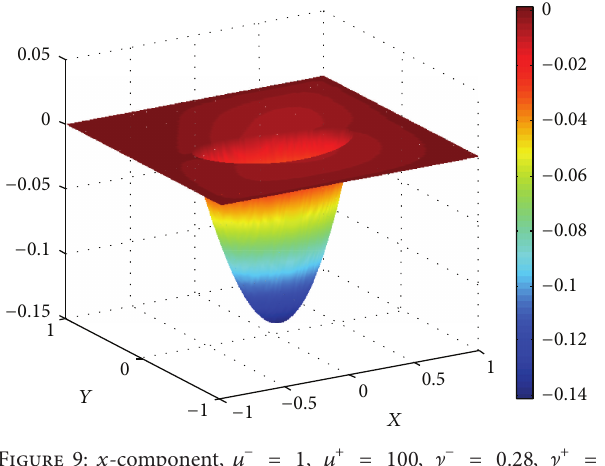
Figure 9: 𝑥 -component, 𝜇 − = 1, 𝜇 + = 100, ] − = 0.28, ] + = = 0.3 unknown 0.4, 𝑟 0